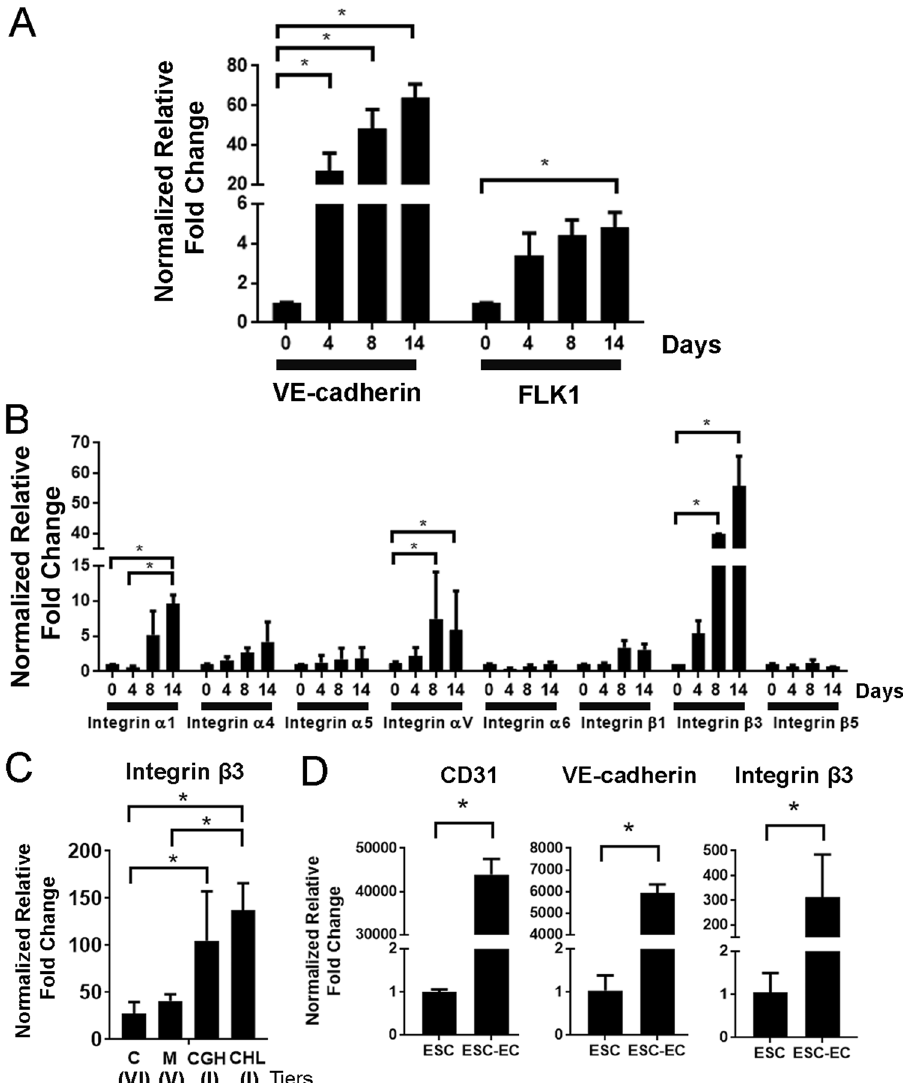
Figure 5. Multiple integrin subtypes were upregulated during endothelial differentiation in ESCs. ( A ) Using a related 14-day endothelial differentiation protocol that encourages endogenous ECM production, gene expression analysis showed that the endothelial markers VE-cadherin and FLK1 were upregulated during the course of differentiation. ( B ) Concomitant with upregulation of endothelial genes, integrins α 1, α V and β 3 were also significantly upregulated through 14 day endothelial differentiation. ( C ) Using a 5-day differentiation protocol, non-purified ESCs (H1) on Tier I combinatorial ECMs (CHL and CGH) had a significant increase in integrin β 3 gene expression, compared to single-factor ECMs such as C (Tier VI) and M (Tier V) (n = 3). ( D ) Purified ESC-derived endothelial cells (ESC-ECs) showed a significant increase in CD31, VE-cadherin, and integrin β 3 gene expression, compared to ESCs (H1) (n = 4). * Denotes P <